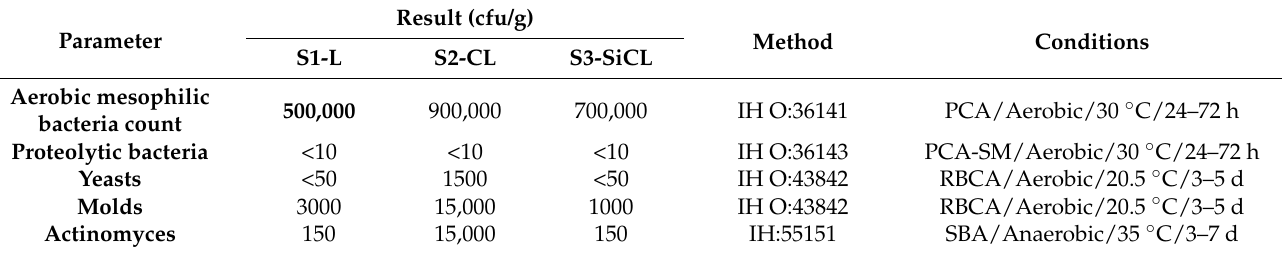
Table 3. Microbial analysis of